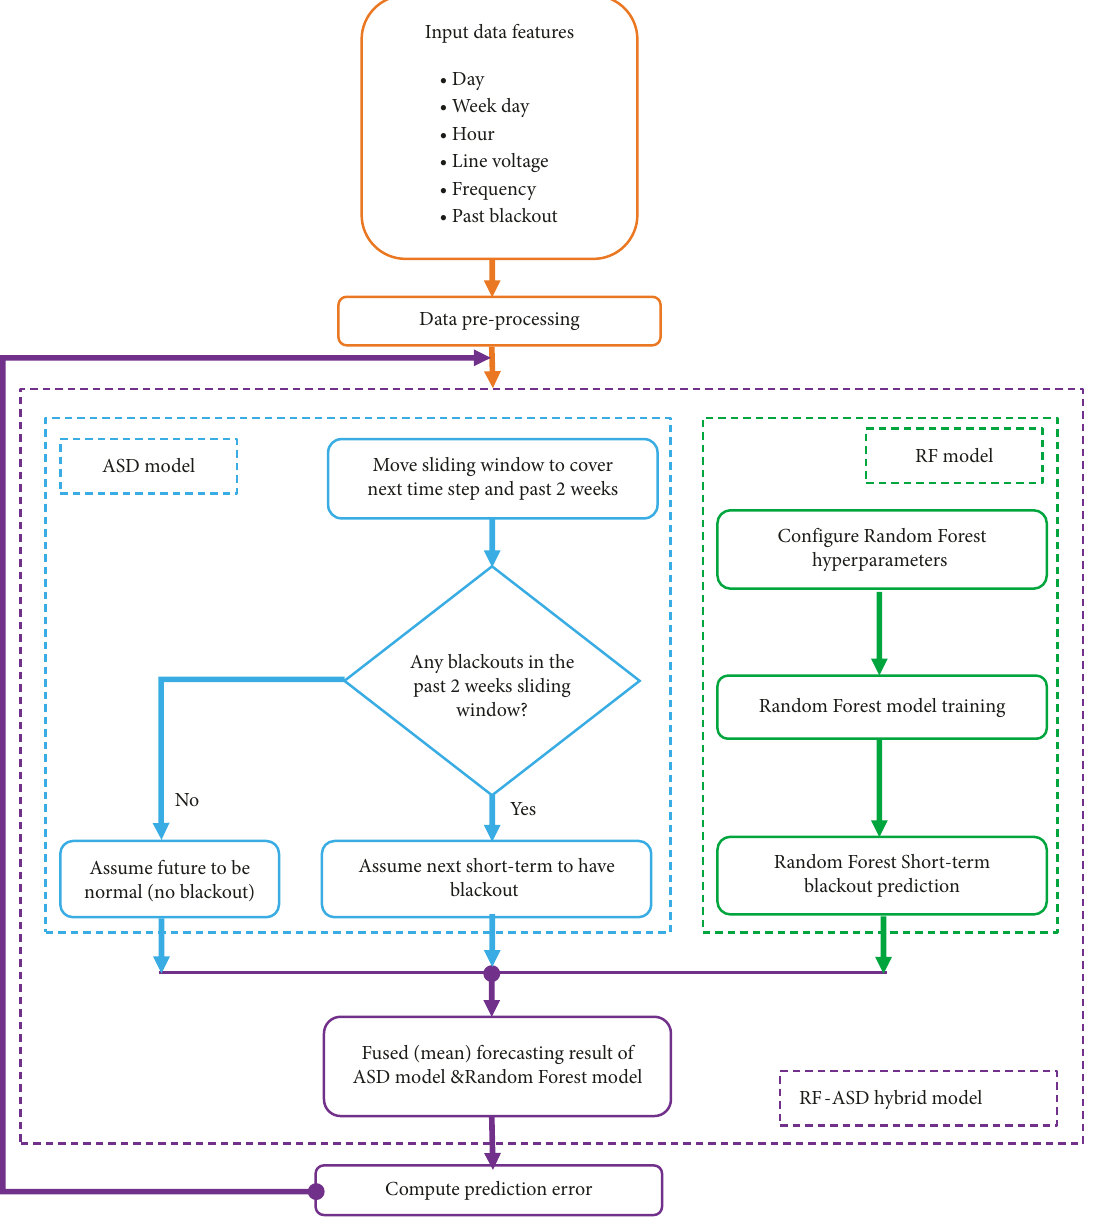
Figure 6: RF-ASD hybrid model algorithm flow